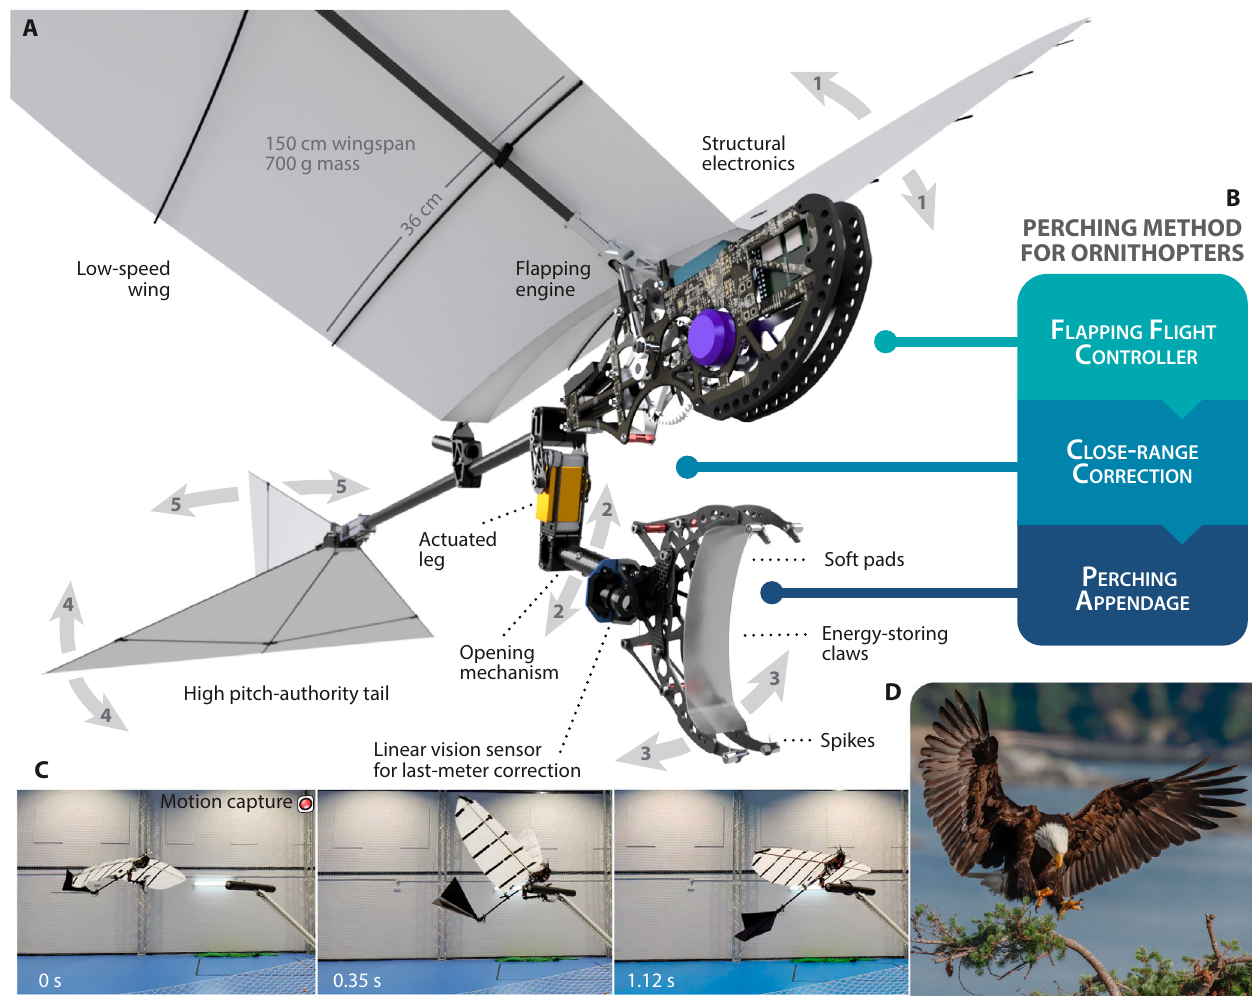
Fig. 1 | Overview and demonstrationofthe perching method. A Rendered view of the leg-claw system with the fl apping-wing robot. The fi ve degrees of freedom are displayed as well as the features necessary for perching fl ights. B The steps of